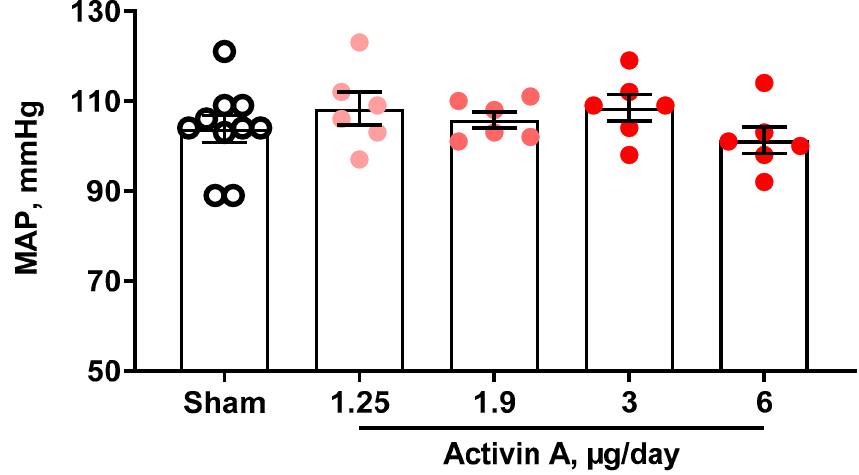
Figure 3. Mean arterial pressure (MAP) on gestational day 19 in sham (open black circles) and pregnant rats infused with 1.25 µ g/day, 1.9 µ g/day, 3 µ g/day, and 6 µ g/day of human recombinant activin A (solid red circles). Data are mean ± SEM. Table 1. Characteristics of sham vs. activin A (6 µ g/day) infused rats on gestational day 19.